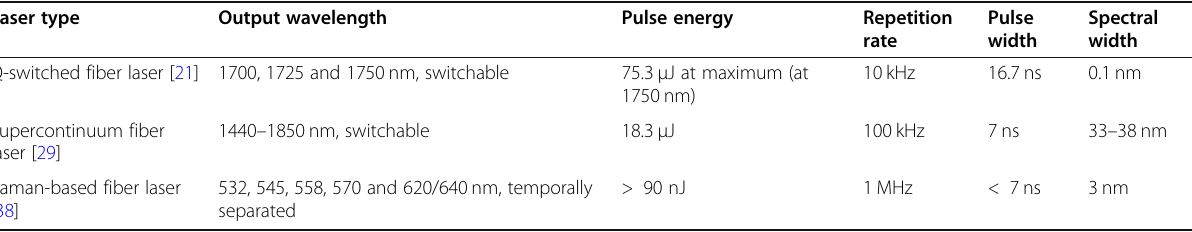
Table 1 Performances of different fiber laser sources for photoacoustic excitation Laser